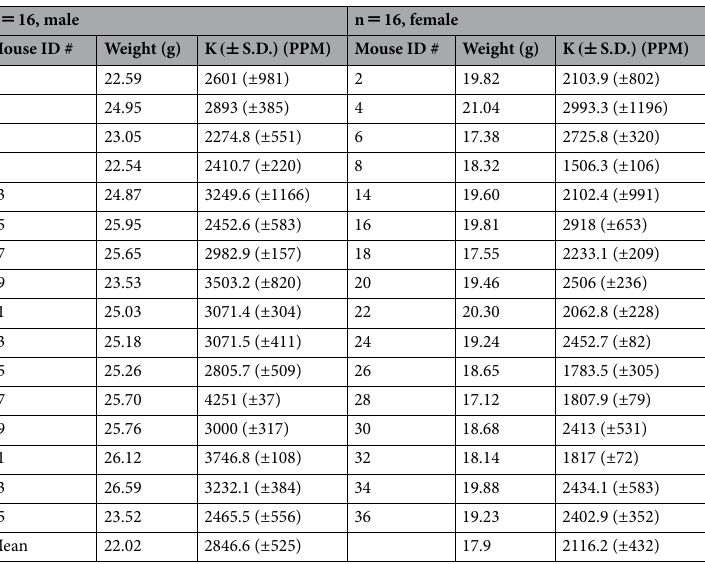
Table 3. Potassium concentration ( mean ± S . D . ) measured in n = 32 mice, with IVNAA, in two sets of the